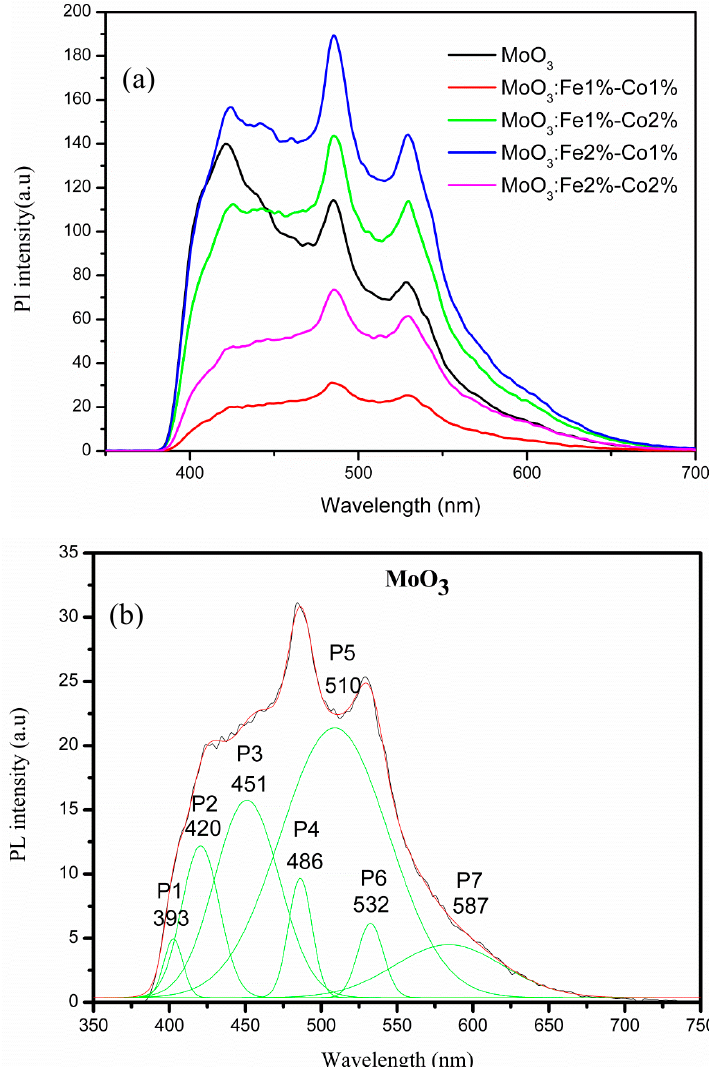
Figure 10. Photoluminescence of MoO 3 : Fe-Co ( a ) and ( b ) Gaussien convolution of PL spectra undoped MoO 3 .